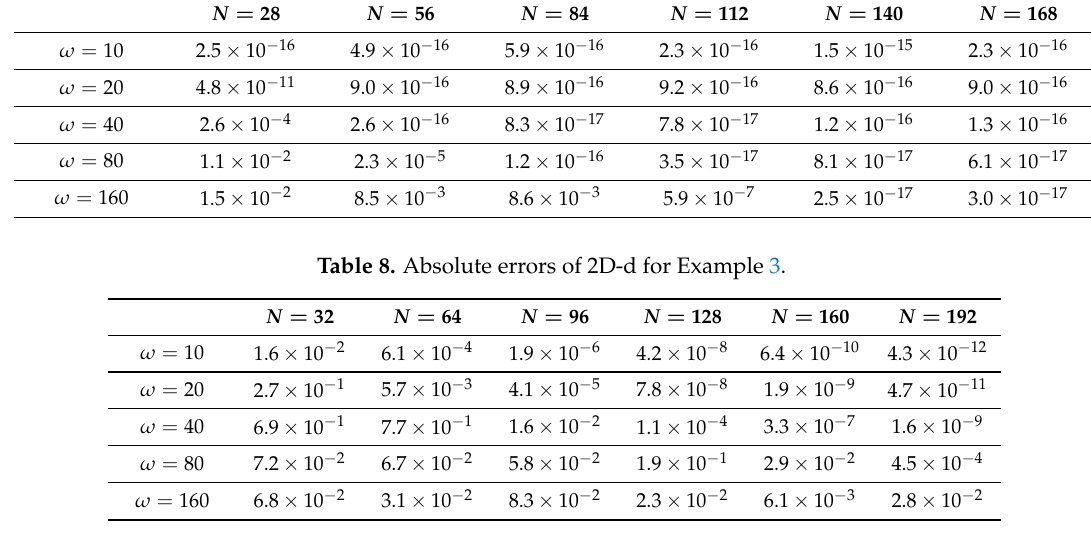
Table 9. Absolute errors of C2DSC-Levin for Example